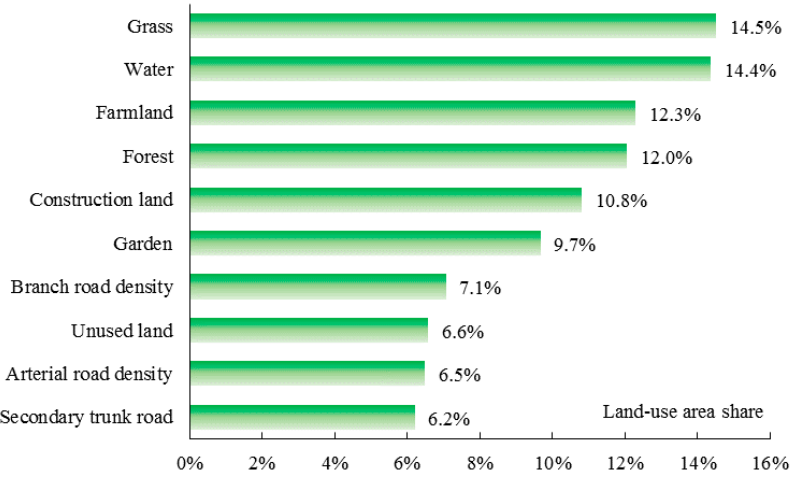
Figure 7. Relative impacts of each land-use distribution on PM 2.5 in summer.